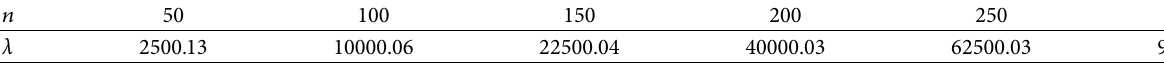
Table 4: For Example 4 with e